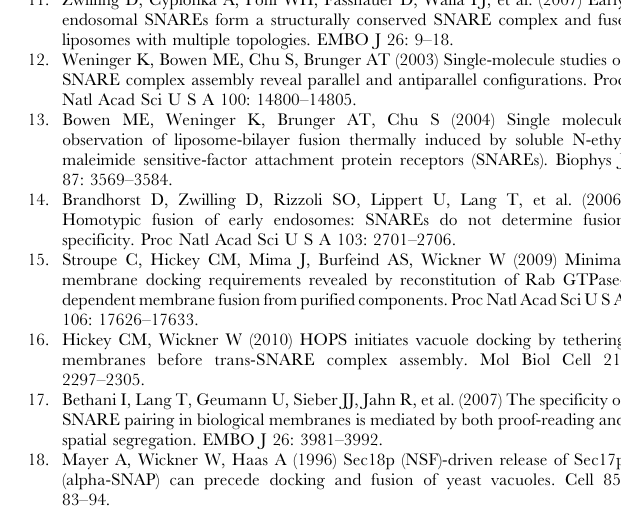
Figure S10 Vam7-expression levels in spheroplast derived from wild type, vps41 D , ypt7T22N , and ccz1 D strains. 50 m g of protein from spheroblasts were loaded on a SDS-PAGE and separated proteins were blotted and probed for the indicated proteins. (TIF) Table S1 Yeast strains used in this study. (PDF) Text S1 Supplementary Materials and Methods.